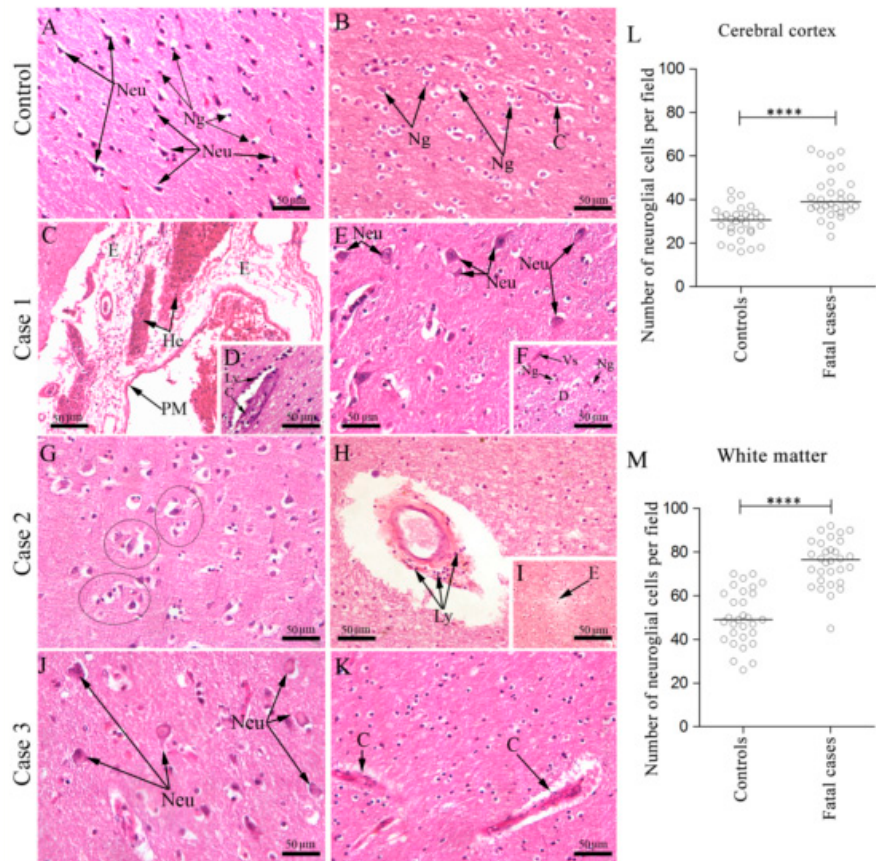
Figure 1. Histopathological analysis of the brain. ( A ) Cortical area of a non-dengue case with regular neurons and neuroglial cells; ( B ) White matter of a non-dengue fatal case with regular neuroglial cells and capillary; ( C ) Brain section of case 1 exhibited edema and hemorrhage areas in the pia-matter, ( D ) numerous mononuclear cells in the capillaries; ( E ) perineuronal vacuolation, ( F ) demyelination areas with presence of neuroglia cells; ( G ) Brain section of case 2 showing many “cuffs” of degenerated neurons and neuroglia cells, ( H ) lymphocytic cells infiltrate around of capillaries, ( I ) and edema; ( J ) Brain section of case 3 exhibiting intense neuronal degeneration ( K ) and thickening of the basement membrane of capillaries. ( L , M ) Neuroglial cells quantification assessed by Mann–Whitney U test, in the cortex and the white matter, respectively. Asterisks indicate statistically significant differences between samples: *** p < 0.0001. Cortical area ( A , E , G , J ) and white matter area ( B – D , F , H , I , K ). WM—